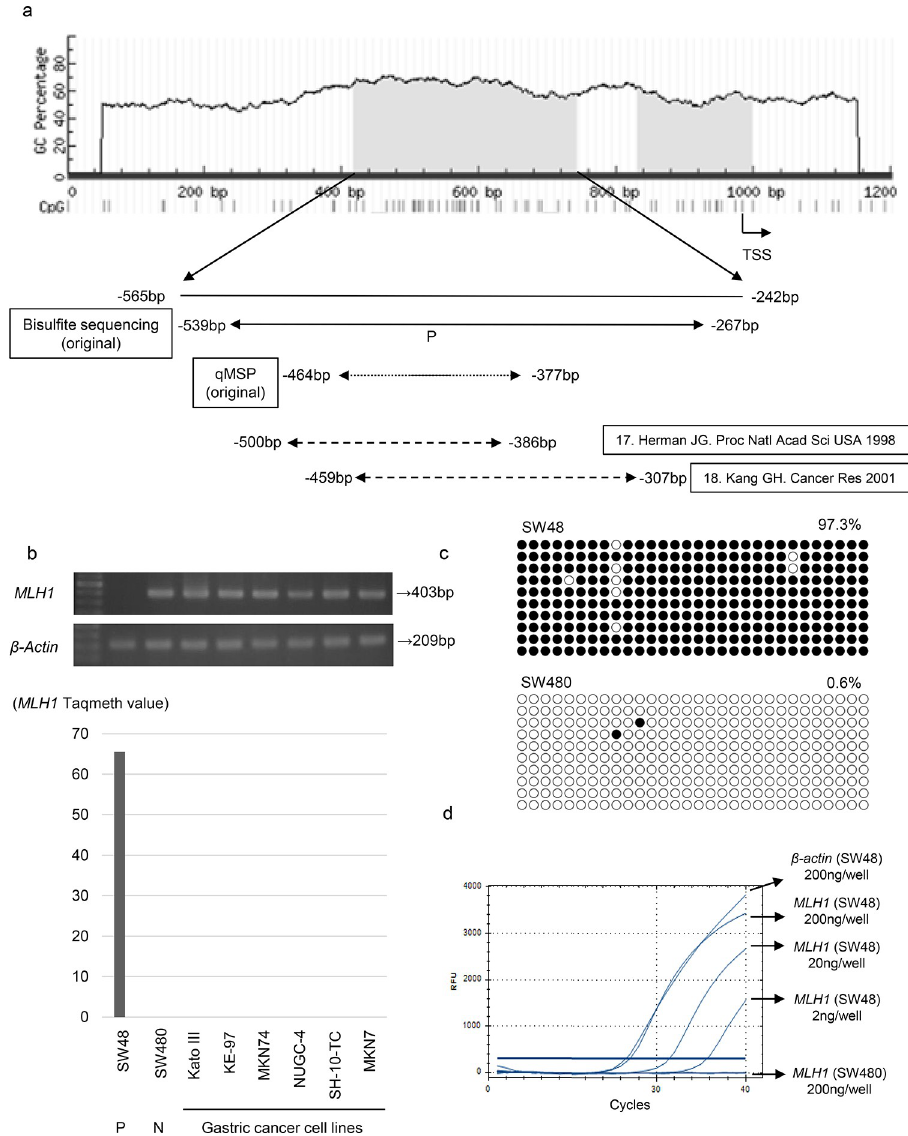
Fig 1. Analysis of MLH1 promoter methylation and expression in gastric cancer cell line and colon cancer cell line. (a) CpG islands (gray area) in the 5 0 -flanking regions of MLH1 (bottom). Solid and dotted lines below the bottom panel indicate the sequences for bisulfite sequencing analysis or quantitative methylation specific PCR (qMSP), respectively. Primer design in early references regarding conventional methylation-specific PCR (reference number 17, 18). The bold line in qMSP (original) indicates the location of the Taqman probe. TSS, translation start site. (b) RT-PCR and qMSP showed silenced expression in SW48 (positive control) with MLH1 hypermethylation, whereas SW480 (negative control) without MLH1 hypermethylation showed definite expression. In addition, RT-PCR proved to be expressed for MLH1 in all 6 gastric cancer cell lines, indicating that no gastric cancer cell lines we have are expected to harbor MLH1 hypermethylation. (c) Methylation status of 30 individual CpG sites (columns) of 10 cloned PCR products (rows), within the MLH1 promoter region by bisulfite sequencing. Open and filled circles, unmethylated and methylated CpG sites, respectively. Numbers denote qMSP value. Results shown for SW48 and SW480 served as positive and negative control. (d) PCR amplification of methylated MLH1 and β -actin